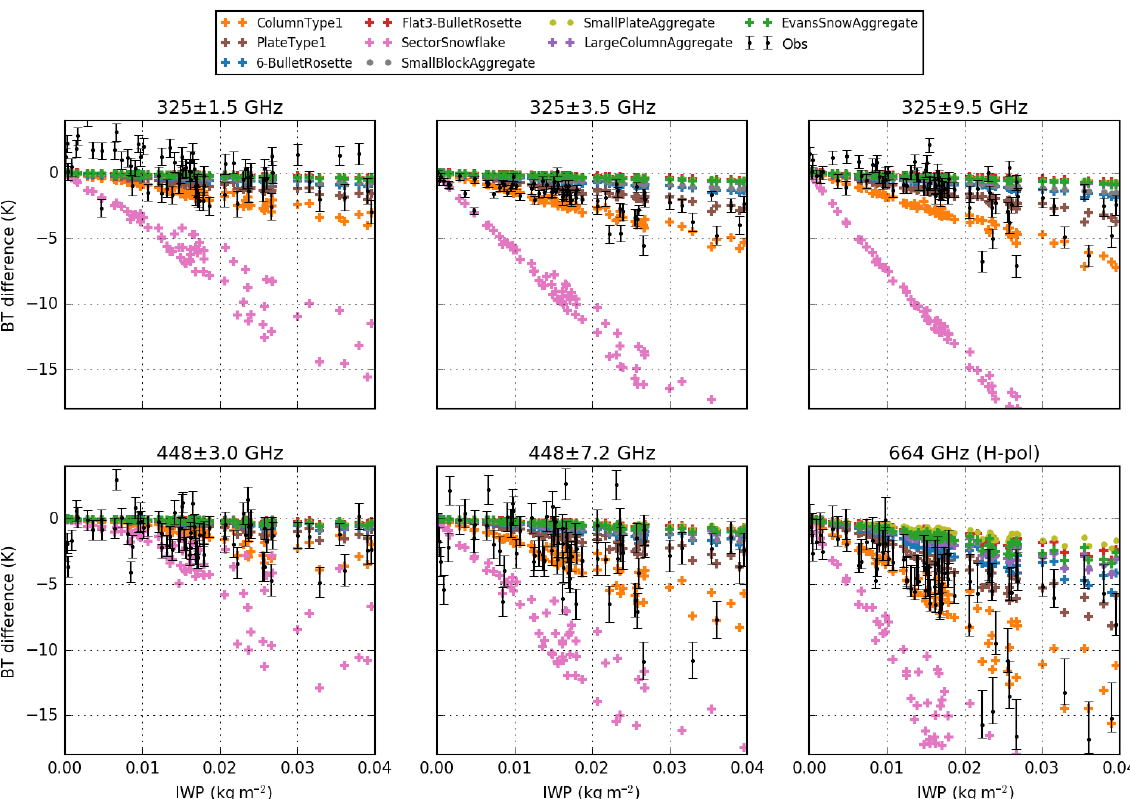
Figure 11. Cloud-induced brightness temperature differences as a function of ice water path for